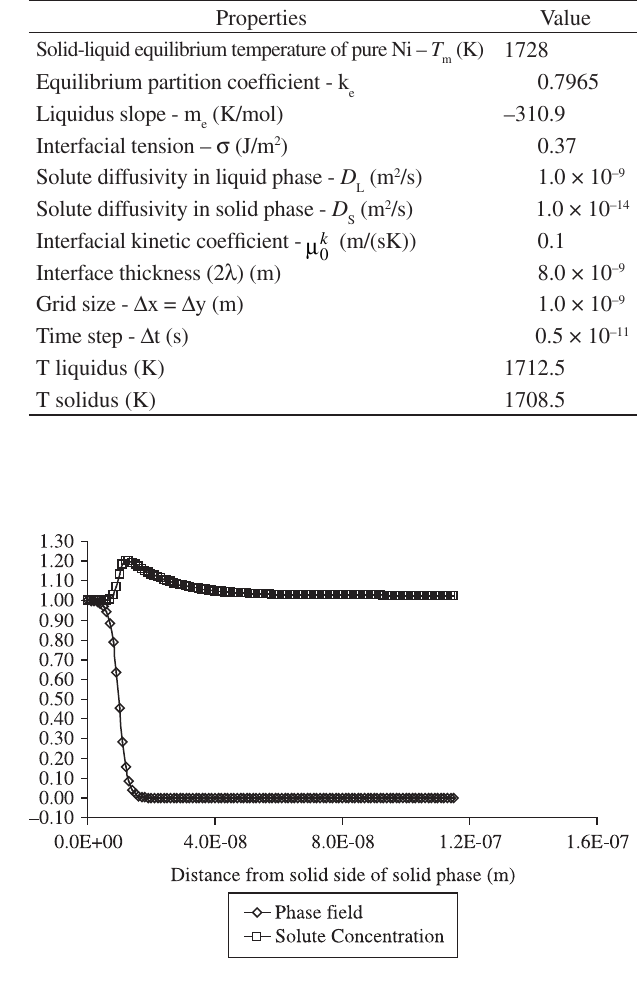
Figure 1. Dimensionless steady state Cu concentration (ratio between actual concentration and solute concentration in solid at solid side of interface) and phase field profile along the y direction determined in the present work using the phase field model of Ramires et al. 7 : solidification velocity = 0.06 m/s